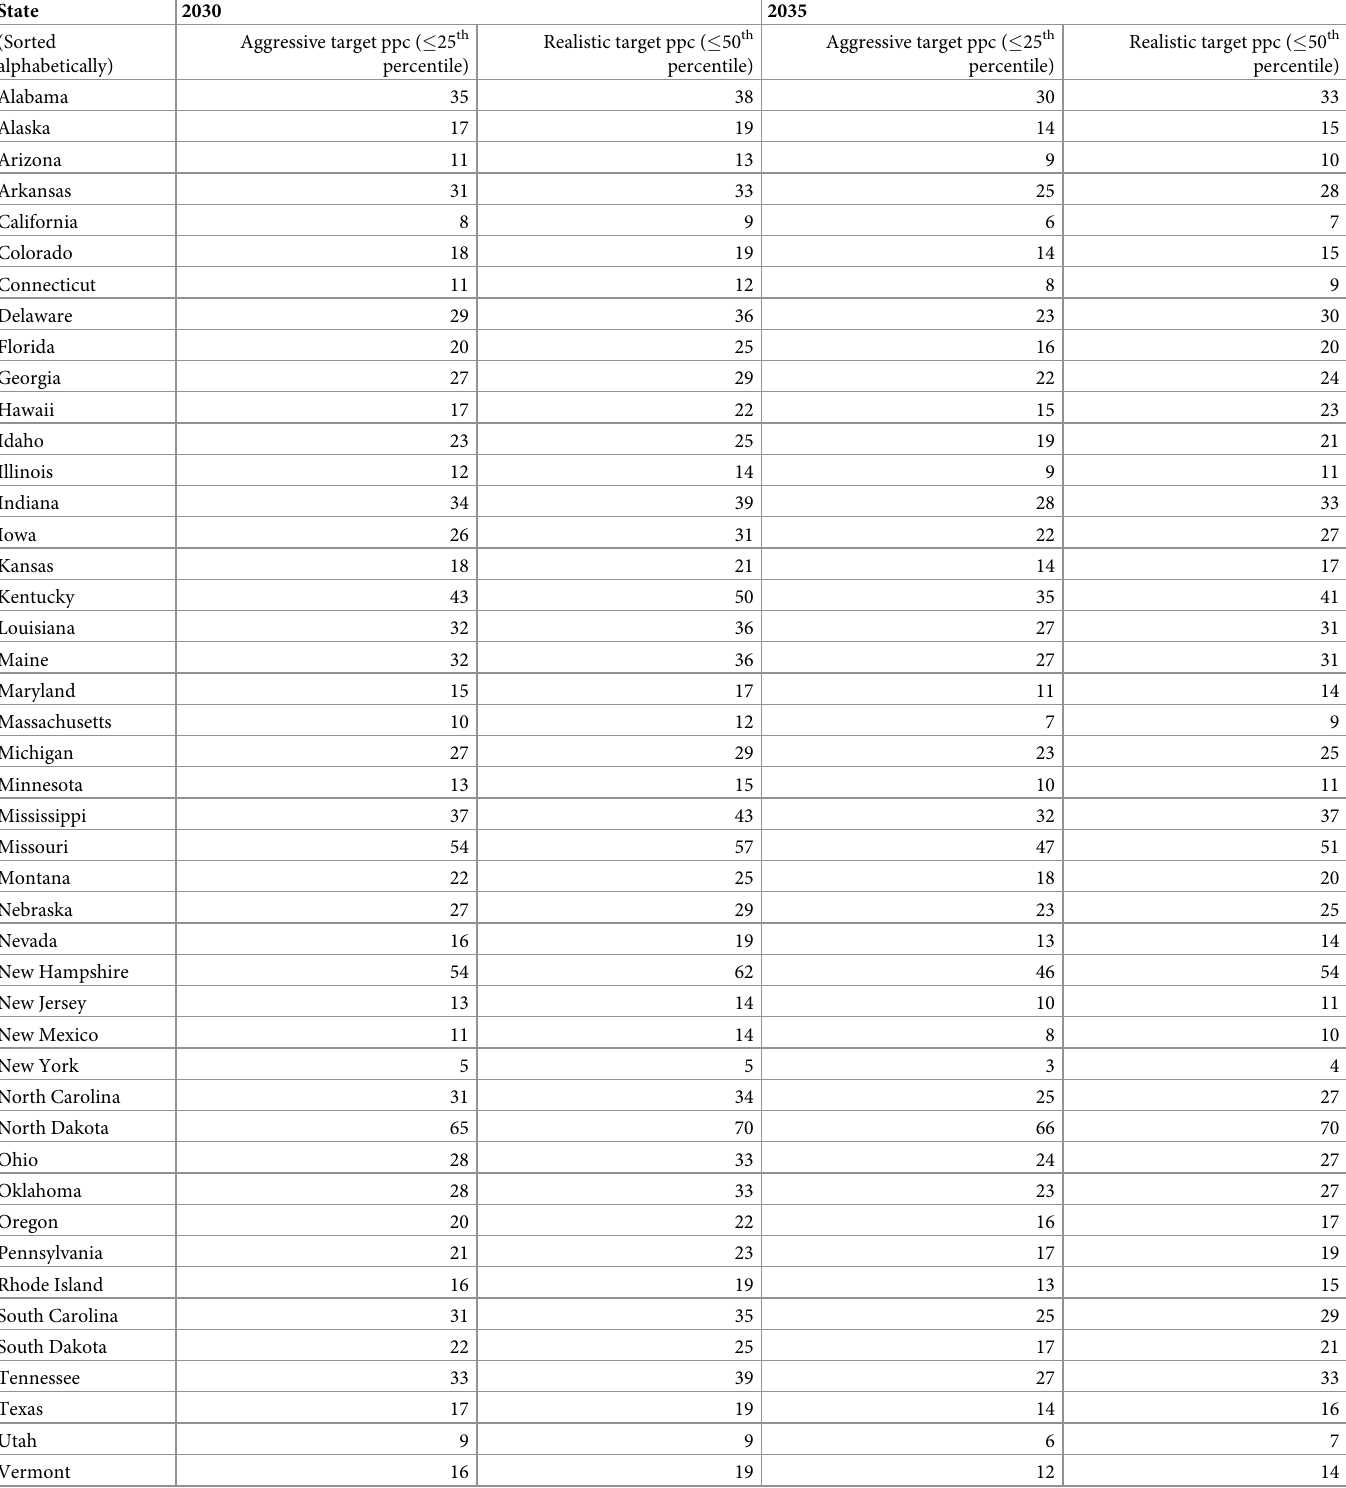
Table 3. Aggressive and realistic cigarette consumption target thresholds for 2030 and 2035 for US